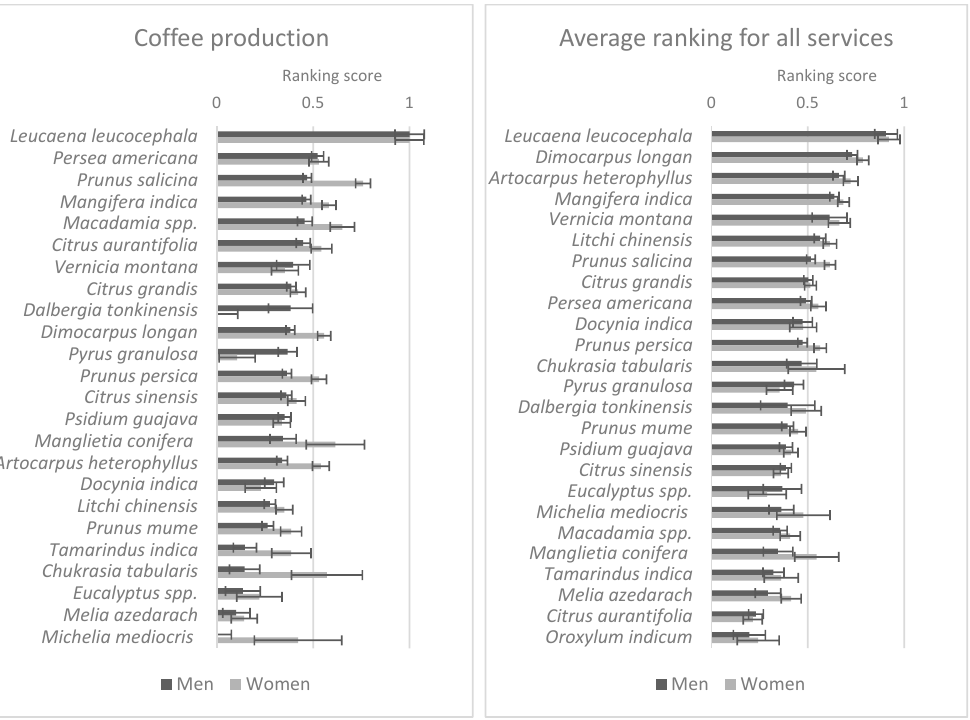
Figure A3. Pairwise ranking of tree species contributing to different tree services in coffee agroforestry systems by gender.